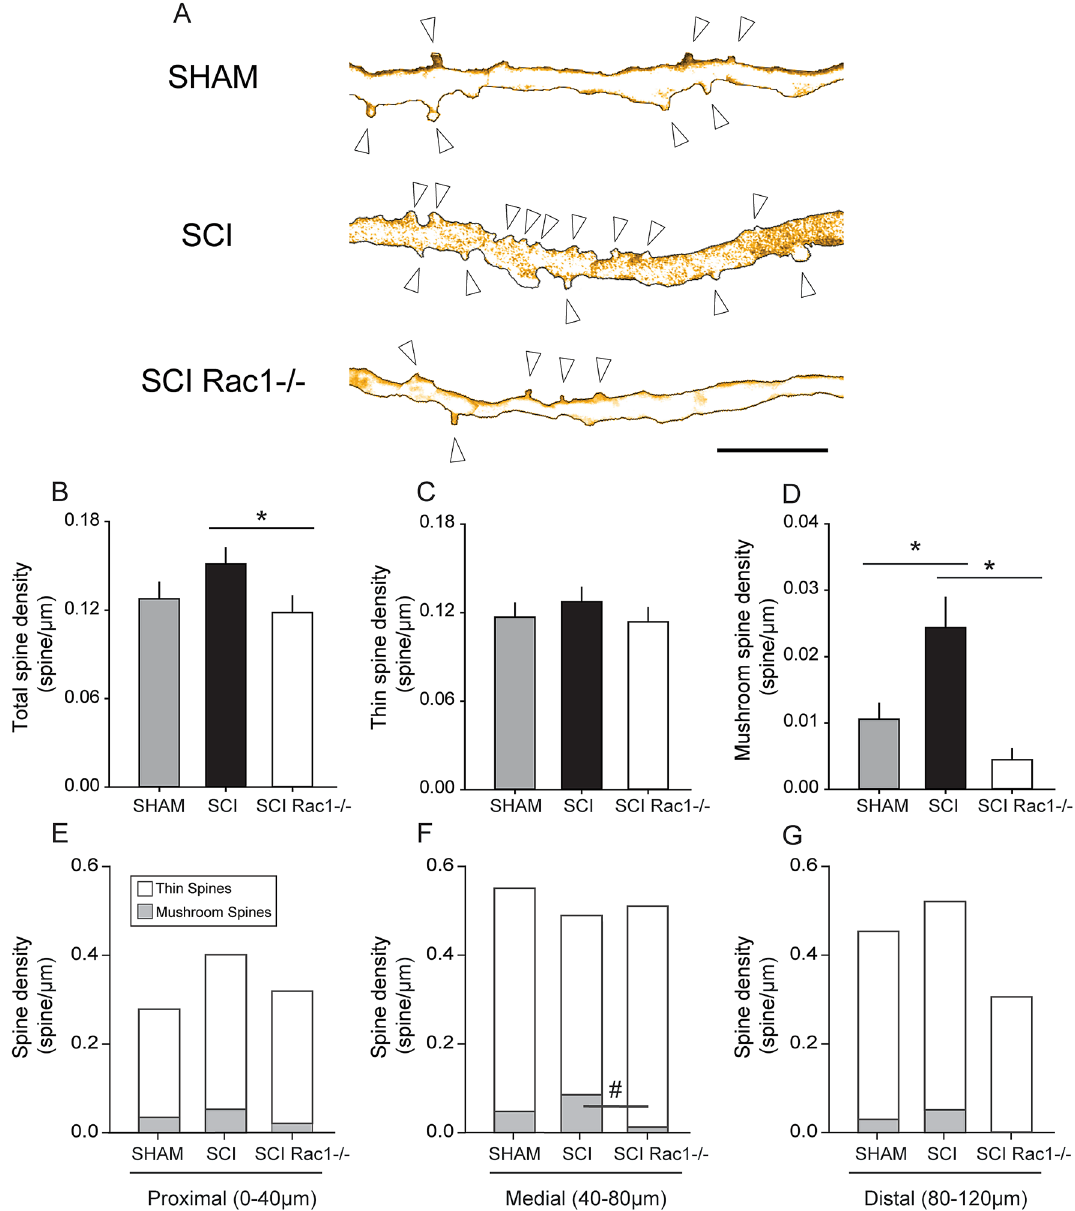
Figure 7. Conditional Rac1 KO in alpha-motor neurons reduces abnormal dendritic spine morphology associated with SCI and hyperreflexia. Analysis of dendritic spine profiles reveals differences in ( B – D ) spine density and ( E – F ) distribution. ( A ) Reconstructed dendritic segments from tdTomato filled spinal motor neurons showing apparent differences in dendritic spine profile between Sham, SCI and SCI Rac1−/− (arrow denotes spine). ( B ) Total spine density, which includes all spines, was significantly lower in the SCI Rac1−/− compared to control (* = p < 0.05). ( C ) There was no difference in the density of thin-shaped spines between groups. ( D ) SCI induced a significant increase in mushroom spine density compared to Sham (* = p < 0.05). In contrast, SCI Rac1−/− reduced mushroom spine density compared to SCI (* = p < 0.05). ( E – G ) Assessment of dendritic spine density within the ( E ) proximal (0–40 µm), ( F ) medial (40–80 µm) and ( G ) distal (80–120 µm) dendritic branches of tdTomato filled motor neurons. ( E , G ) Dendritic spine density was not different within the proximal or distal region between Sham, SCI and SCI Rac1−/−. ( F ) SCI induced an increase in mushroom spine density in the medial region, which was not observed in SCI Rac1−/− animals (# = p < 0.05). Graphs are mean ± SEM. Scale bar in ( A ) = 10